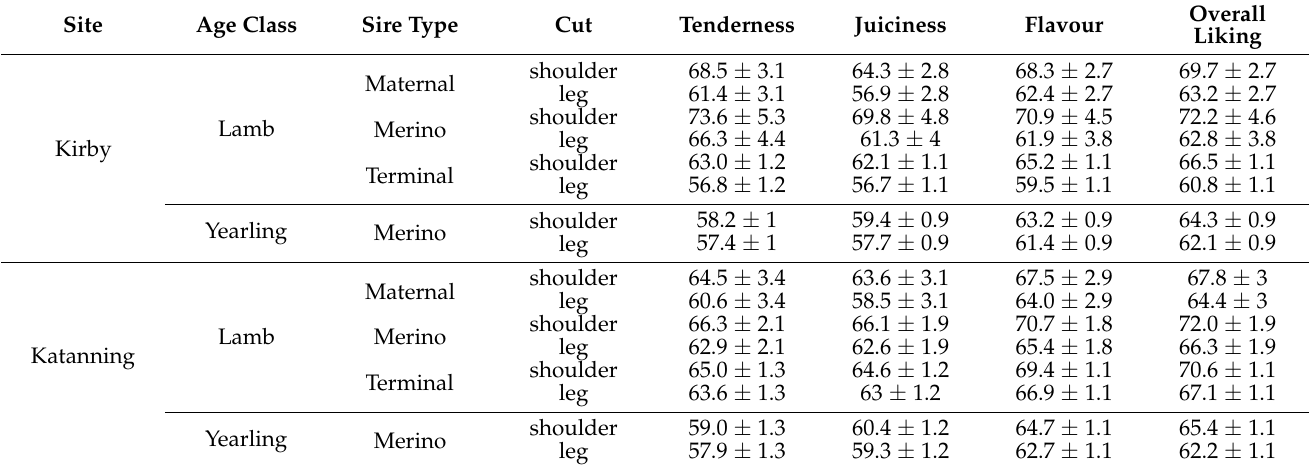
Table 4. Least square means ± SE for effects of sire type-age class and sire type-age class by site between shoulder and leg cuts for degree of tenderness, juiciness, liking of flavour and overall